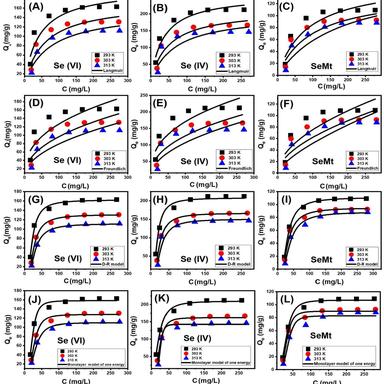
Fitting of the adsorption results with the different equilibrium models including Langmuir model (A, B, and C), Freundlich model (C, D, and E), D-R model (F, G, and H), and Monolayer model of one energy (J, K, and L).